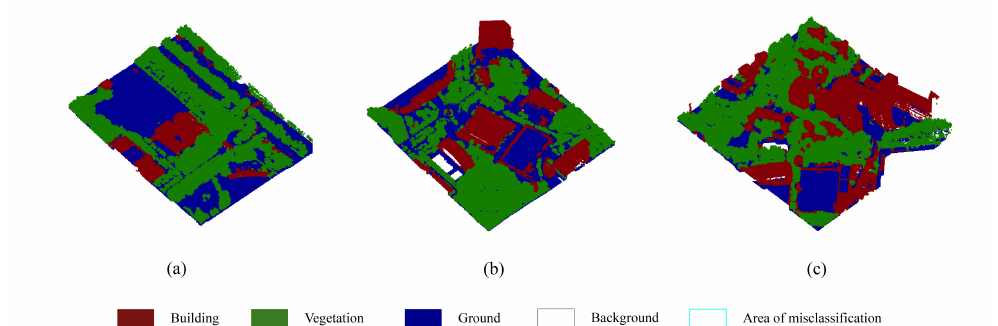
Figure 10. Classification results of airborne LiDAR-generated Shenzhen sites. Three selected sites have been marked as ( a – c ).